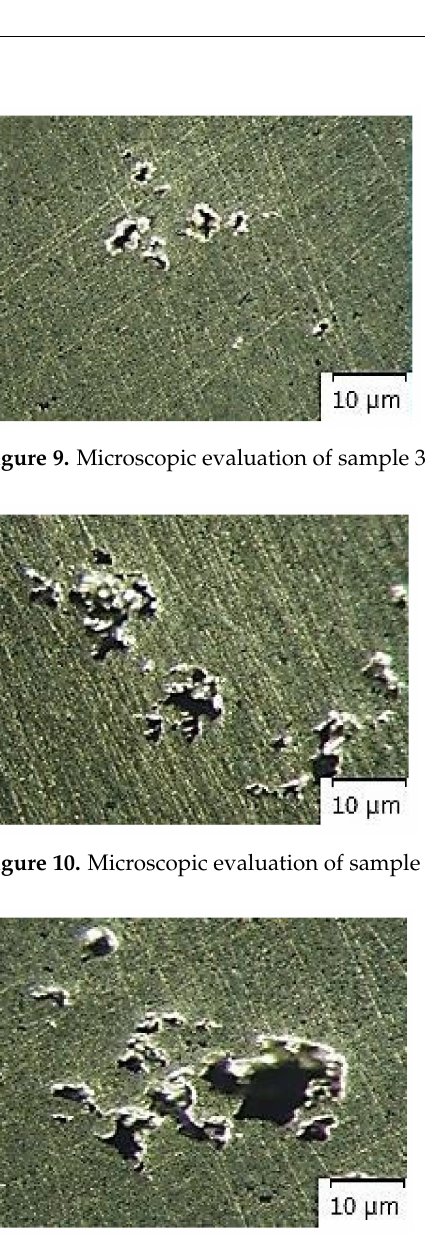
Figure 11. Microscopic evaluation of sample 5/ ×